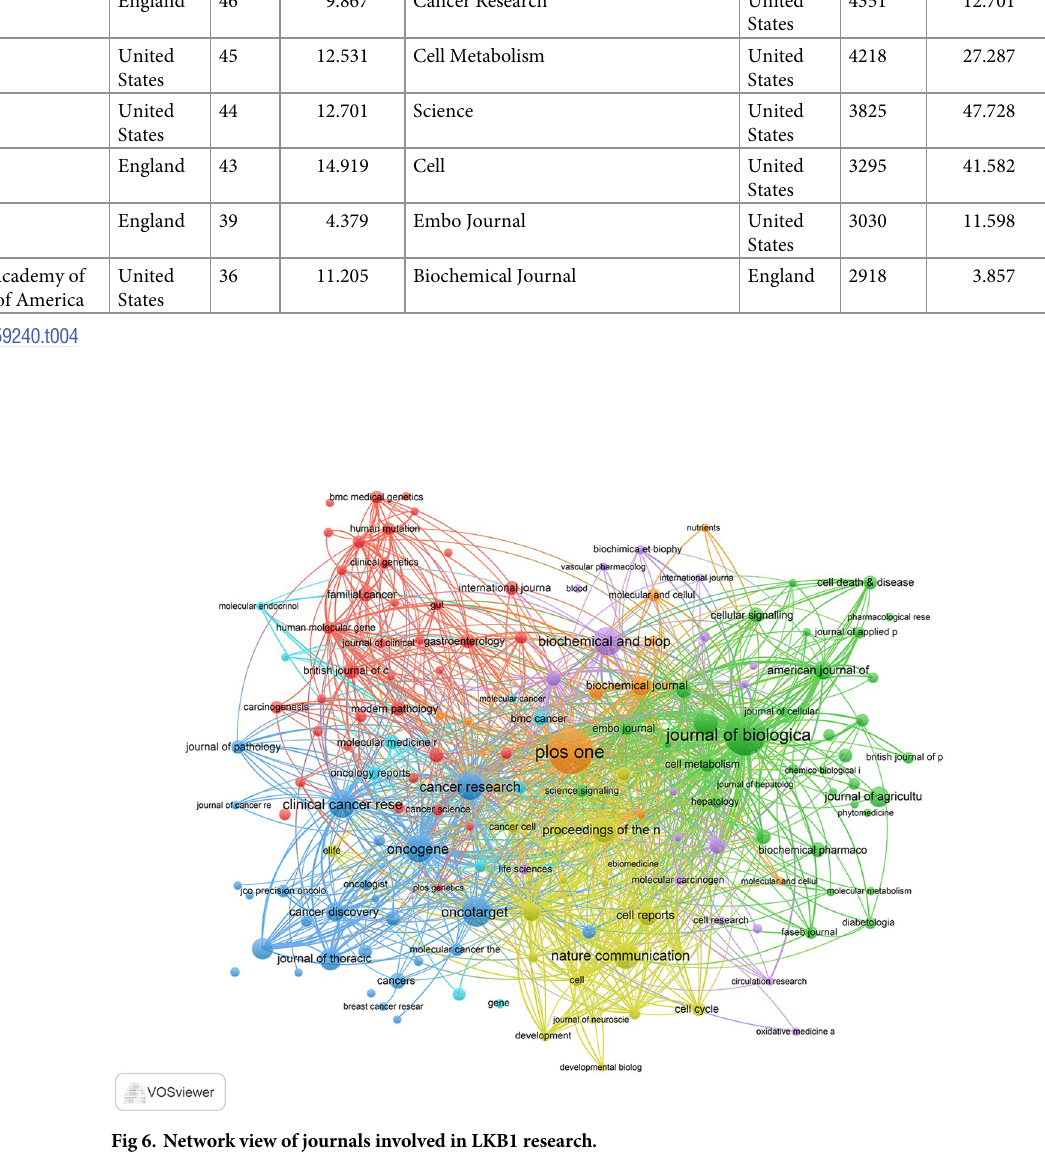
Fig 6. Network view of journals involved in LKB1